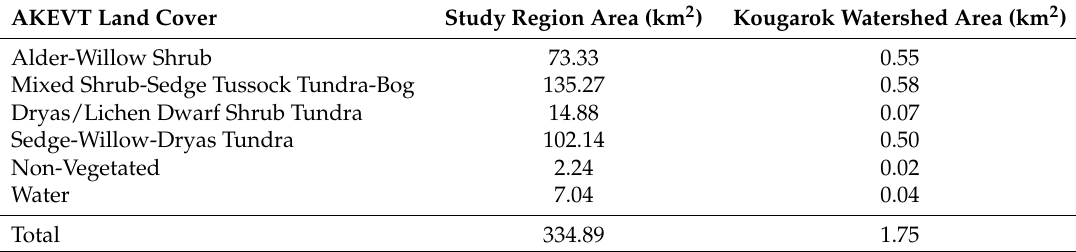
Figure 6. Validation scores against the 30 field vegetation plots, AKEVT ( a ), UCVM- k 10 ( b ), UCVM- k 25 ( c ), and UCVM- k 50 ( d ). The precision, recall, and f1-score scores are displayed by k value ( e ). (AW: Alder-Willow Shrub; DL: Dryas/Lichen Dwarf Shrub Tundra; MS: Mixed Shrub-Sedge Tussock Tundra-Bog; NV: Non-Vegetated; SW: Sedge-Willow-Dryas Tundra, and W: Water). Table 3. Area distribution of vegetation classes for UCVM map based on k = 50 within the entire study region and the Kougarok